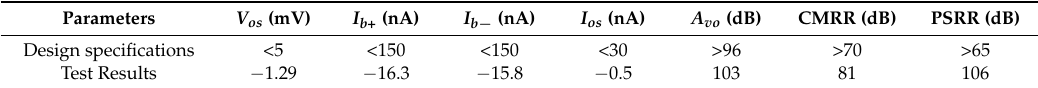
Table 3. Main parameters of the ASIC.